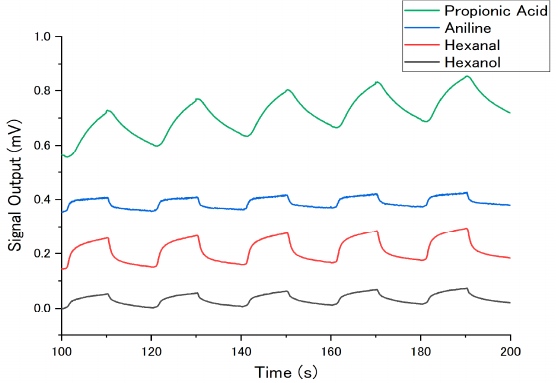
Figure 5. Sensing signals of iron porphine at 25 °C, 2% in partial vapor concentration, 0% RH.